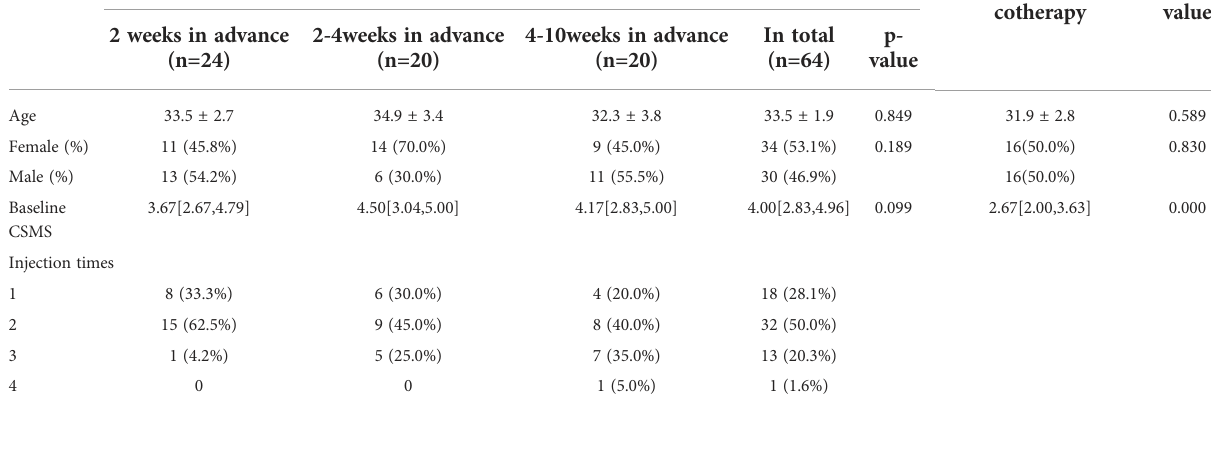
TABLE 1 Baseline information of participants